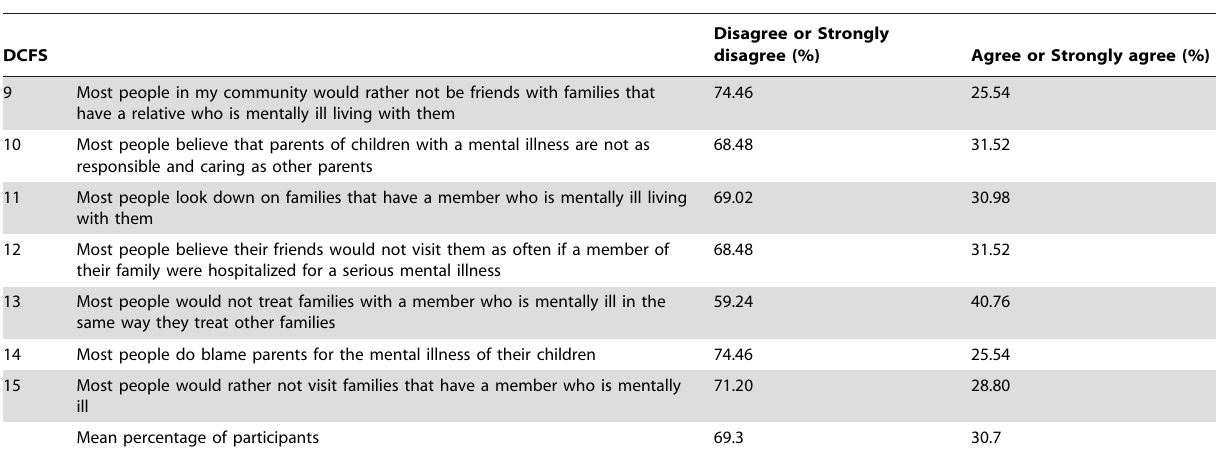
Table 2. Patient’s responses on statements of the DCFS (N= 184).